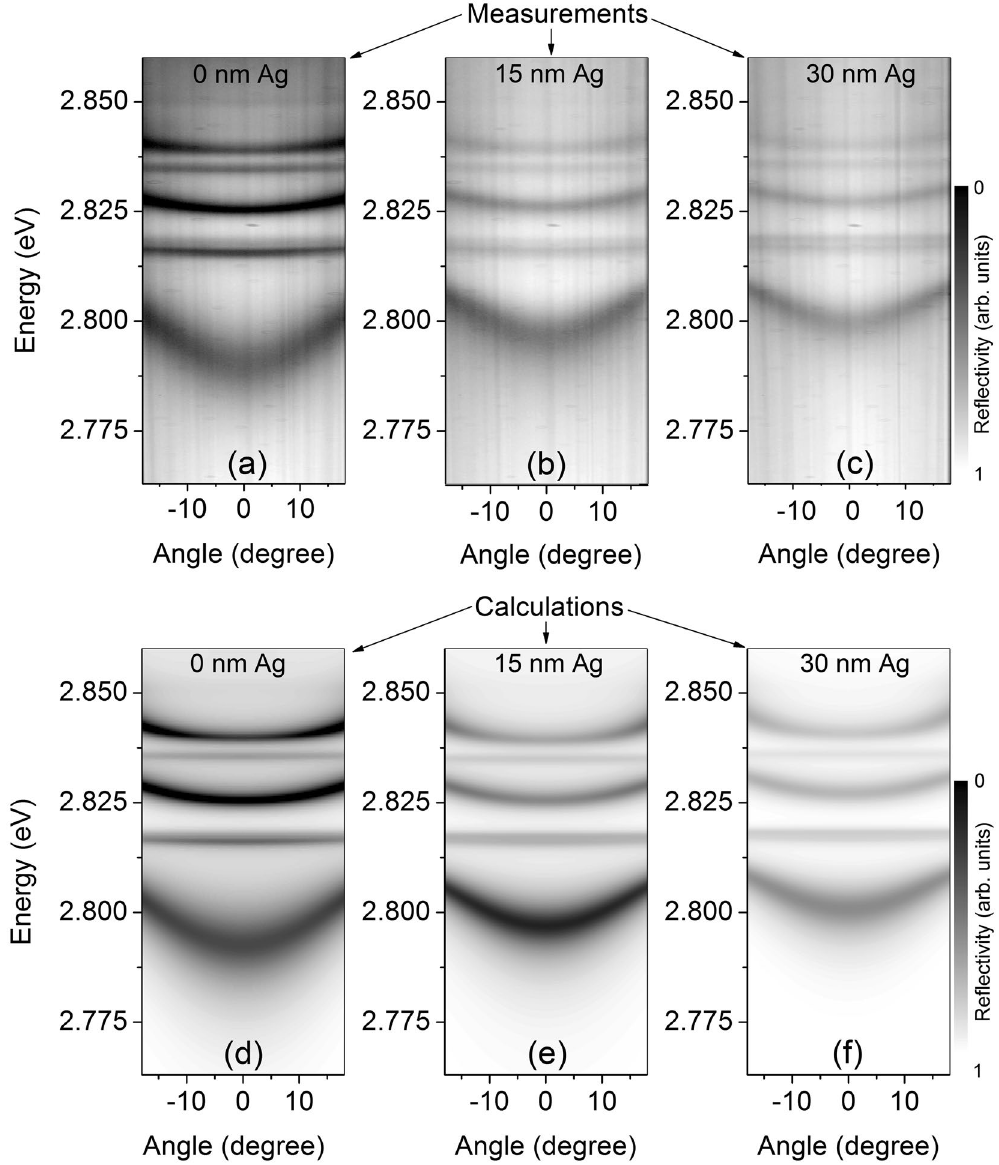
Figure 5. ( a – c ) Angle resolved microreflectivity measurement of the Bragg polariton dispersion for different thicknesses of the Ag layer. The experimental results are compared to the calculated dispersions ( d – f